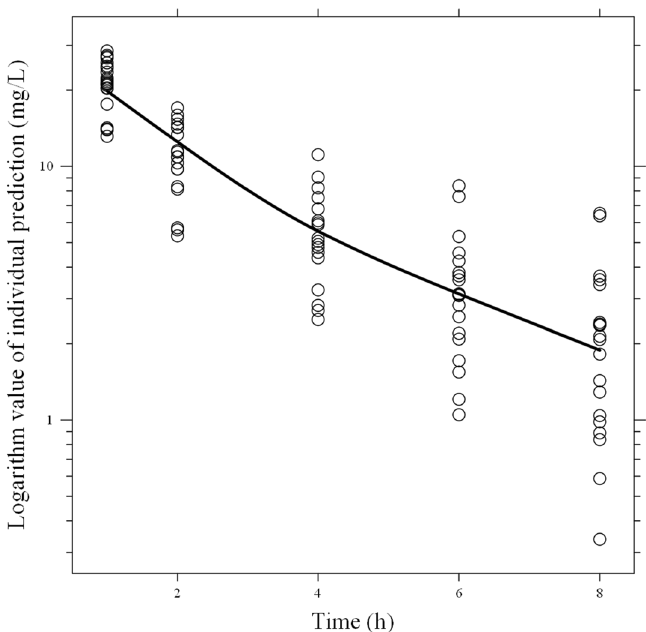
Figure 3. Semi-logarithm plot of individual prediction versus time. The solid line shows the smooth fitting for individual